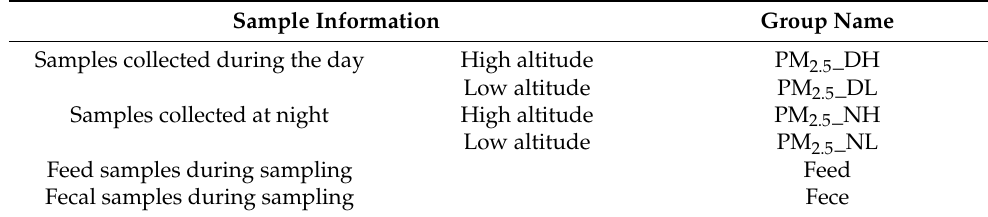
Table 1. Sample information and group